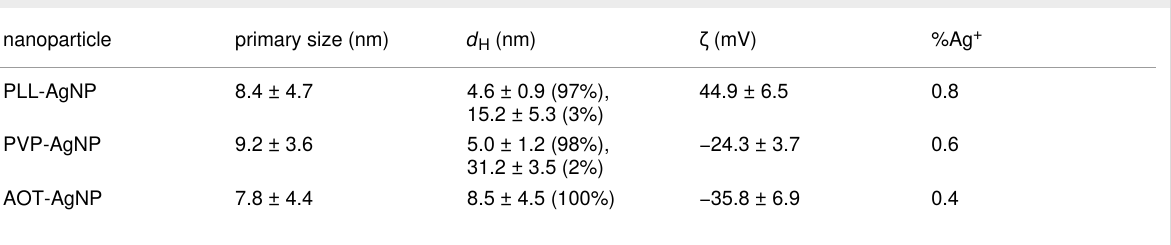
Table 2: Values of primary size (obtained by TEM), hydrodynamic diameter ( d H ), zeta potential ( ζ ), and percentages of released ionic silver in colloidal suspension of AgNPs coated with PLL, AOT, or PVP.